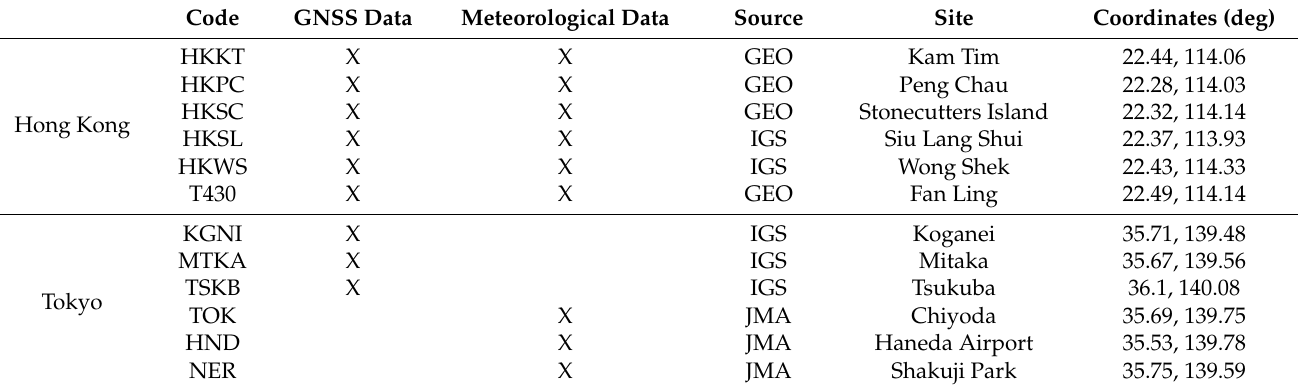
Table 1. Selected GPS and meteorological stations used in this study to monitor the AUHI intensity levels in Hong Kong and Tokyo.